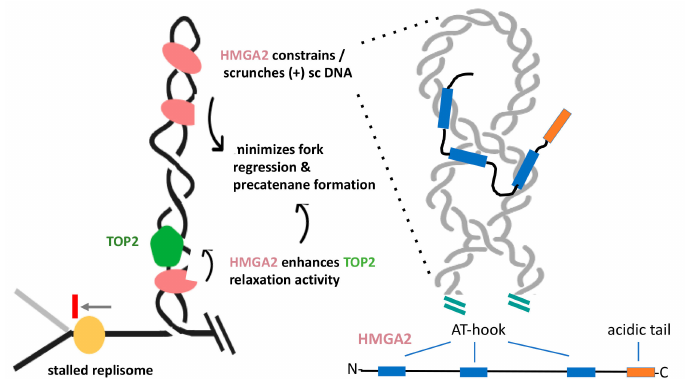
Figure 4. Proposed model depicting HMGA2’s role as a supercoil sink at topologically challenged replication forks. ( Left ) HMGA2 preferentially binds to and constrains supercoiled DNA and enhances TOP2-mediated supercoil relaxation. These activities stabilize the replisome and attenuate both precatenane formation and fork regression. ( Right ) Supercoil constrainment requires multiple AT-hook binding domains of HMGA2, which, based on results obtained with atomic force microscopy [102], bind to duplex segments at a DNA crossing in a plectoneme. This association will temporarily stabilize the supercoil and thus neutralize at least some of the torque experienced by the stalled replisome. Because HMGA2 appears to be able to form homodimers [105], it is possible that multiple HMGA2 molecules are working together at such a location and, furthermore, that this constrained DNA conformation represents a favorable substrate for